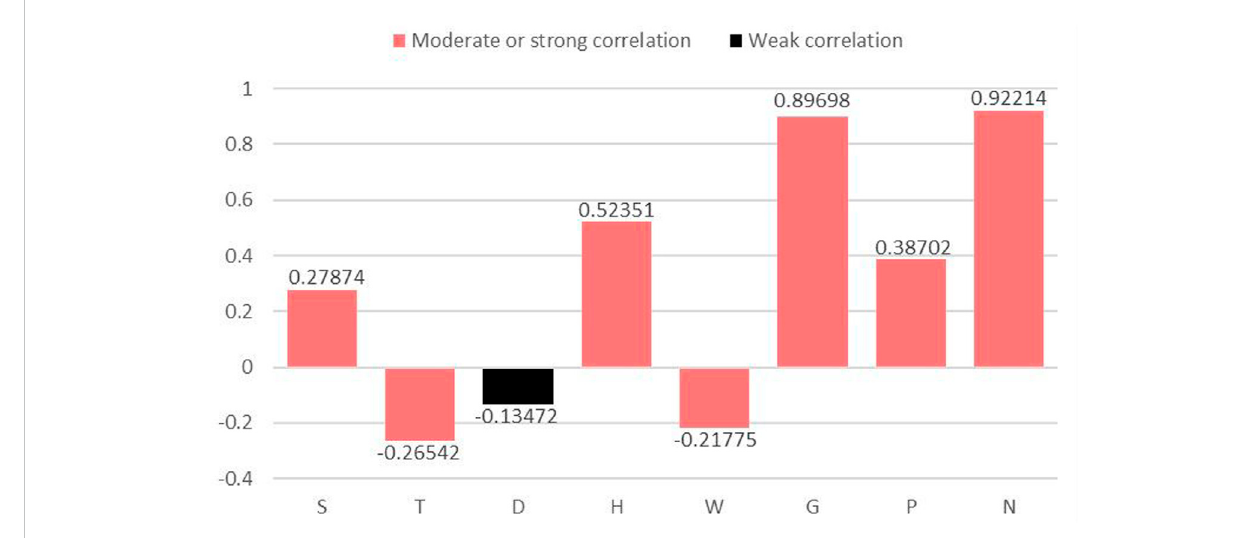
FIGURE 4 The SCC of in fl uencing factors bar chart.